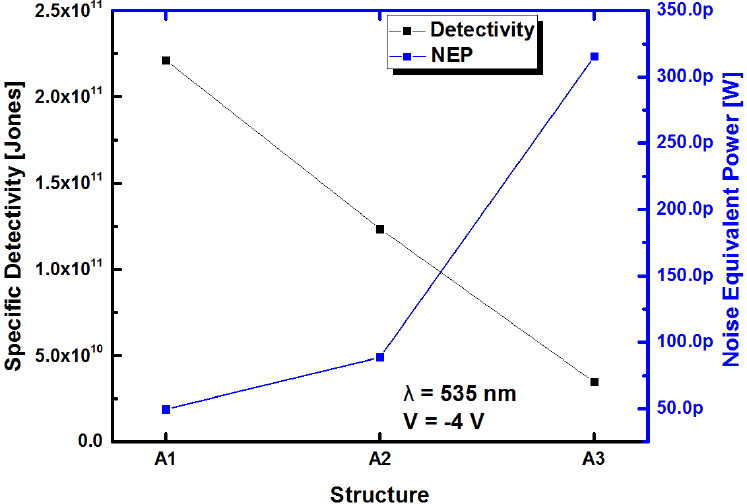
Figure 19. Specific Detectivity and noise equivalent characteristics of the Au/SRO/Si structures.